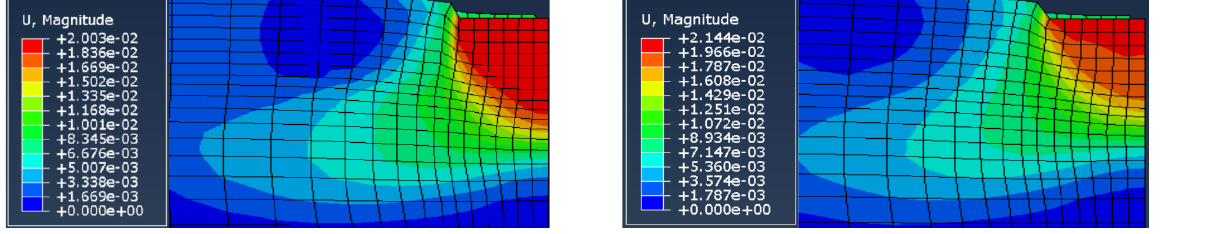
Figure 14 : Displacement contours of case 1 at h/B = 0.7 for L/B=1. Figure 15 : Displacement contours of case 8 at h/B = 0.7 for L/B=1.